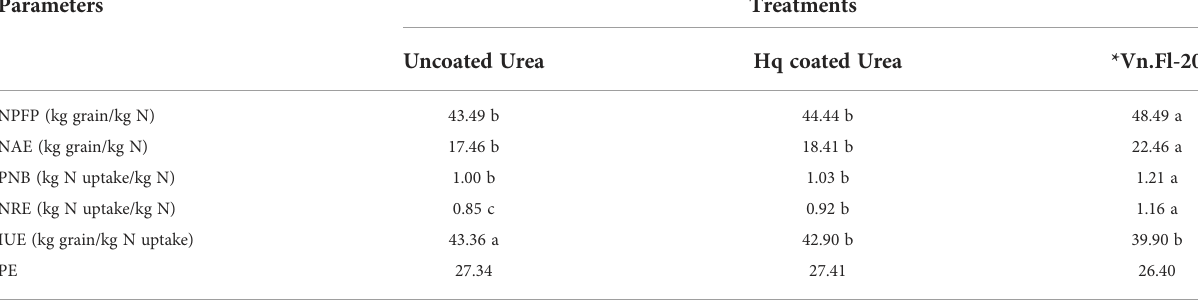
TABLE 6 Comparative effect of Vachellia nilotica extract and hydroquinone (Hq) coated urea on the components of nitrogen use ef fi ciency (NUE) of wheat under fi eld conditions (2020 – 21).